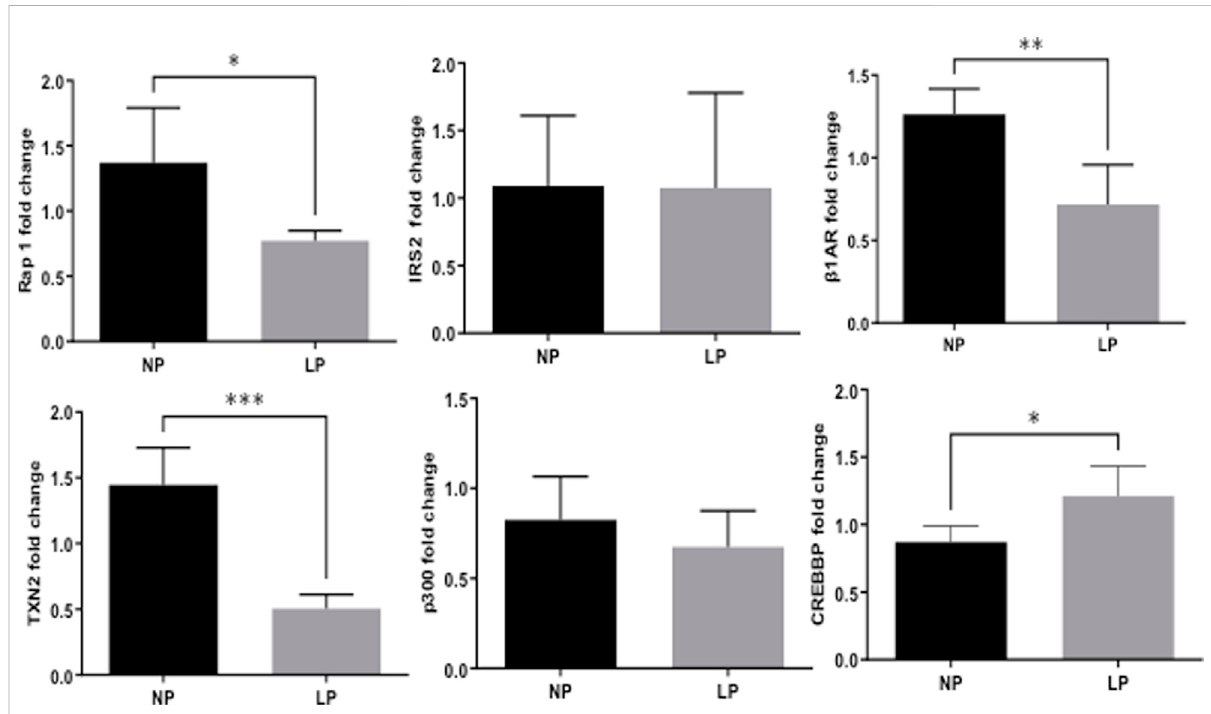
FIGURE 6 Fold-change of mRNA expression in LP offspring ( n = 5) compared to age-matched NP progeny ( n =